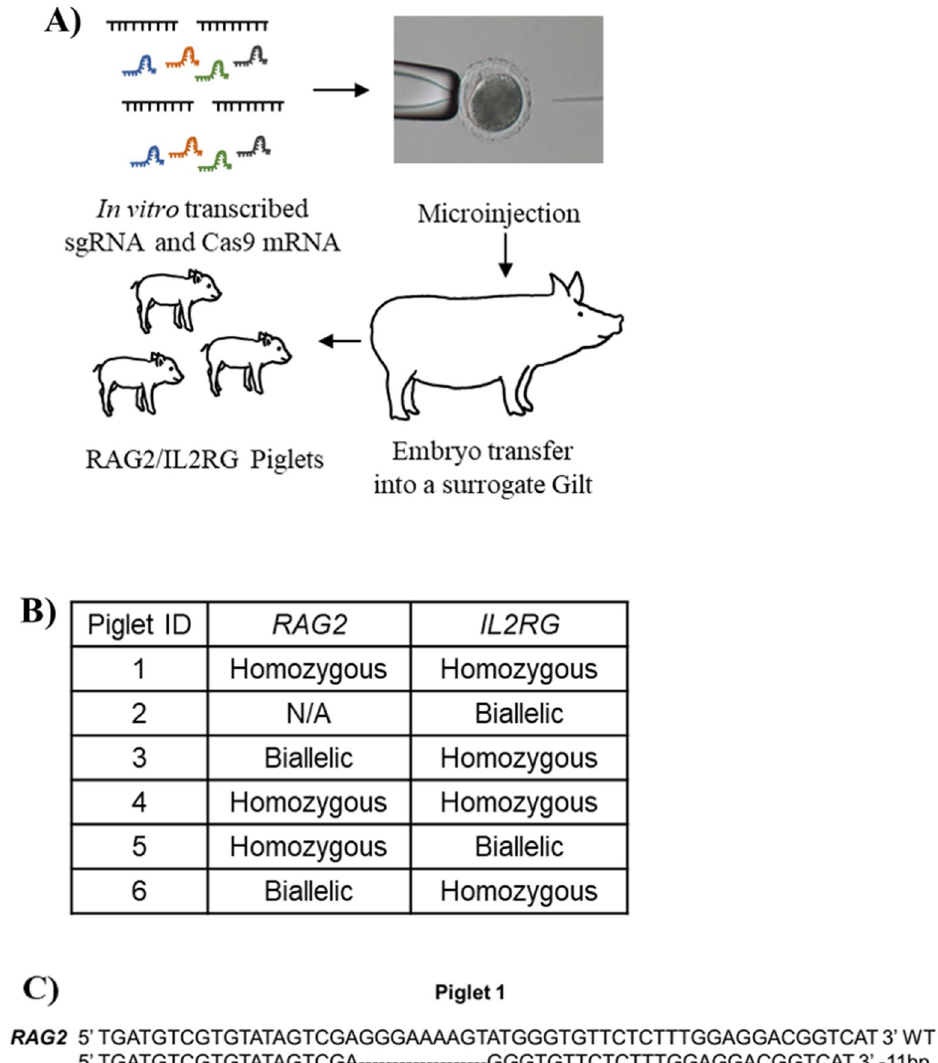
Figure 1. Generation of RAG2 / IL2RG knockout pigs. ( A ) Schematic approach for RAG2/IL2RG knockout pig production. First, the sgRNA and Cas9 mRNA was synthesized via in vitro transcription. Second, an optimal concentration of sgRNA and Cas9 was injected into presumable zygotes. Third, the injected embryos were transferred into a surrogate gilt. At the end of gestation, piglets were born via hysterectomy and maintained in gnotobiotic isolators. ( B ) Summary of piglet genotypes in IL2RG and RAG2 gene. Six piglets were born and analyzed. During PCR analysis, RAG2 was not amplified from the Piglet #2 DNA sample, suggesting a large deletion. Biallelic genotype indicates two differently modified alleles. Homozygous indicates one type of modified alleles. ( C ) Genotype of Piglet 1 as a representation of small deletions or insertions introduced by the CRISPR/Cas9